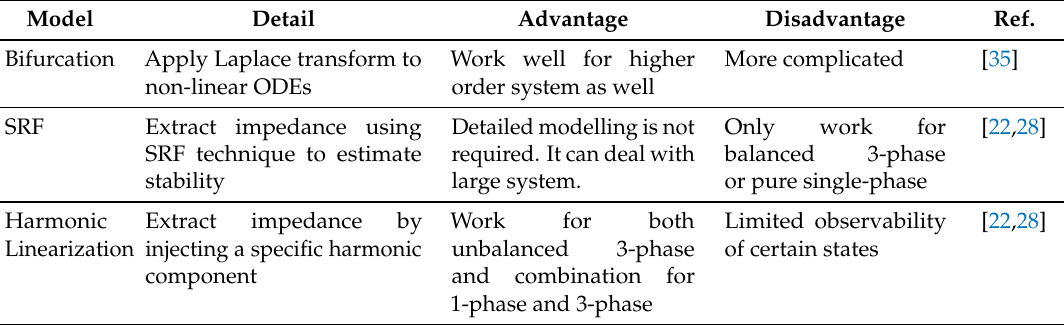
Table 2. Comparative Analysis of Different Stability Techniques in Frequency Domain.